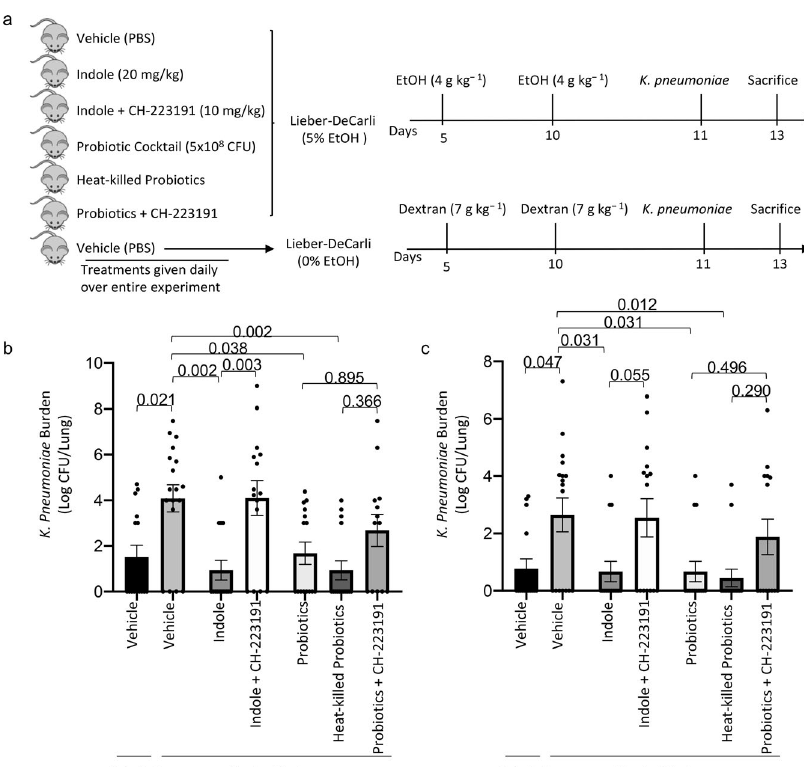
Fig. 3 Indole and probiotic treatment mitigates alcohol-associated pneumonia via aryl hydrocarbon receptor signaling. Binge-on-chronic alcohol-fed mice with and without treatment were infected with Klebsiella and sacri fi ced 48 h post-infection. a Experimental schema. b Klebsiella lung burden (Log CFU/ ml). c Klebsiella splenic burden (Log CFU/ml). Bars represent the mean ± SEM and dots represent individual mice. P values are indicated in the fi gure and were determined by one ‐ way ANOVA with Sidak ’ s multiple comparison test. N =